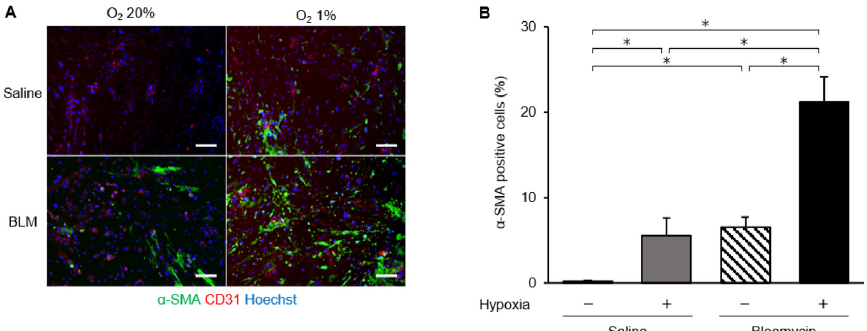
Figure 5. Hypoxia-induced changes of α -SMA staining in endothelial cells. ( A ) Representative fluorescence microscopy images of endothelial cells from saline- and bleomycin-treated lungs, cultured under normoxic (20%) and hypoxic (1%) conditions. The α -SMA (green) and CD31 (red) stained images were merged with those showing a nuclear stain (Hoechst, blue). Scale bars indicate 100 µ m. ( B ) Comparison of the percentage of α -SMA-positive endothelial cells from saline- and bleomycin-treated lungs, cultured under normoxic (20%) and hypoxic (1%) conditions. The percentage of α -SMA-positive cells is expressed as the percentage of the total cell number, estimated from Hoechst 33342 nuclear staining. Data are means ± standard error from three mice. * p < 0.05.